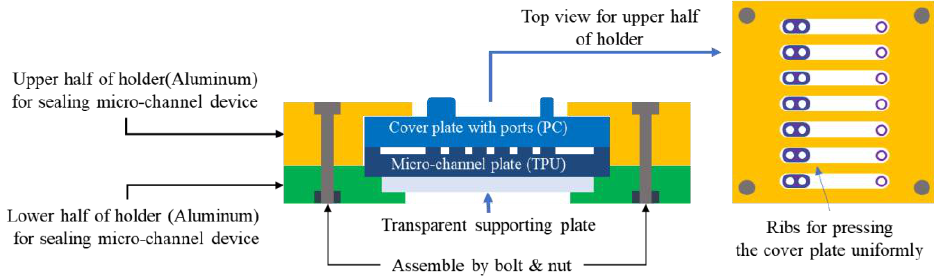
Figure 4. Schematic of a holder for assembling a micro-channel plate and a cover plate .